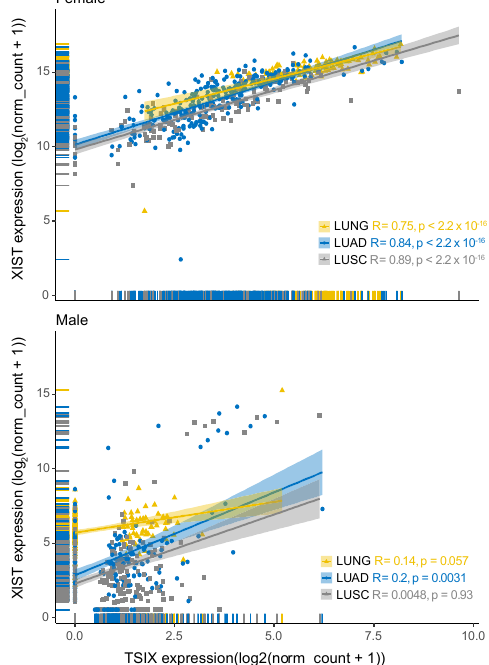
Figure 5. Correlation with regression line for gene expression (in units if log2(norm_count + 1)) for XIST vs. TSIX, Spearman’s rank correlation test was used to generate the correlation coefficient represented as R in the analyses, p represents p -value. Healthy lung, LUAD, and LUSC were compared separately in both sexes. Total sample number is 1299, 794 derived from male patients and 505 from female patients. There are 116 samples from male patients with 0 expression in XIST, 461 in TSIX. In female patients derived samples, 17 show zero expression for TSIX gene. All samples with zero expression in both genes were removed from the analysis.